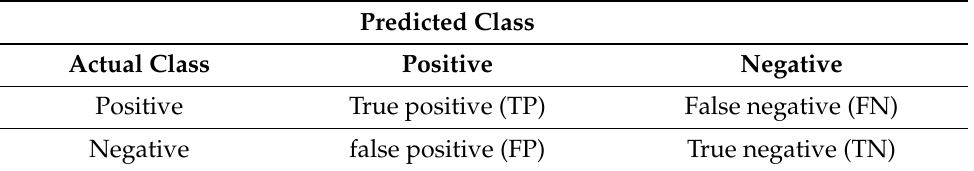
Table 5. Confusion Matrix explanation for binary